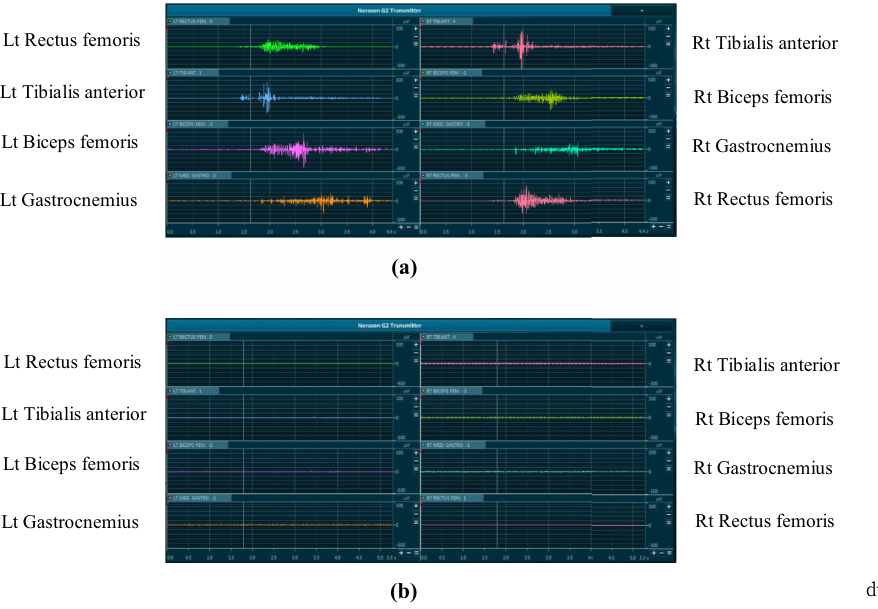
Figure 1. An example of the EMG measurement during physical (a) and imagined STS